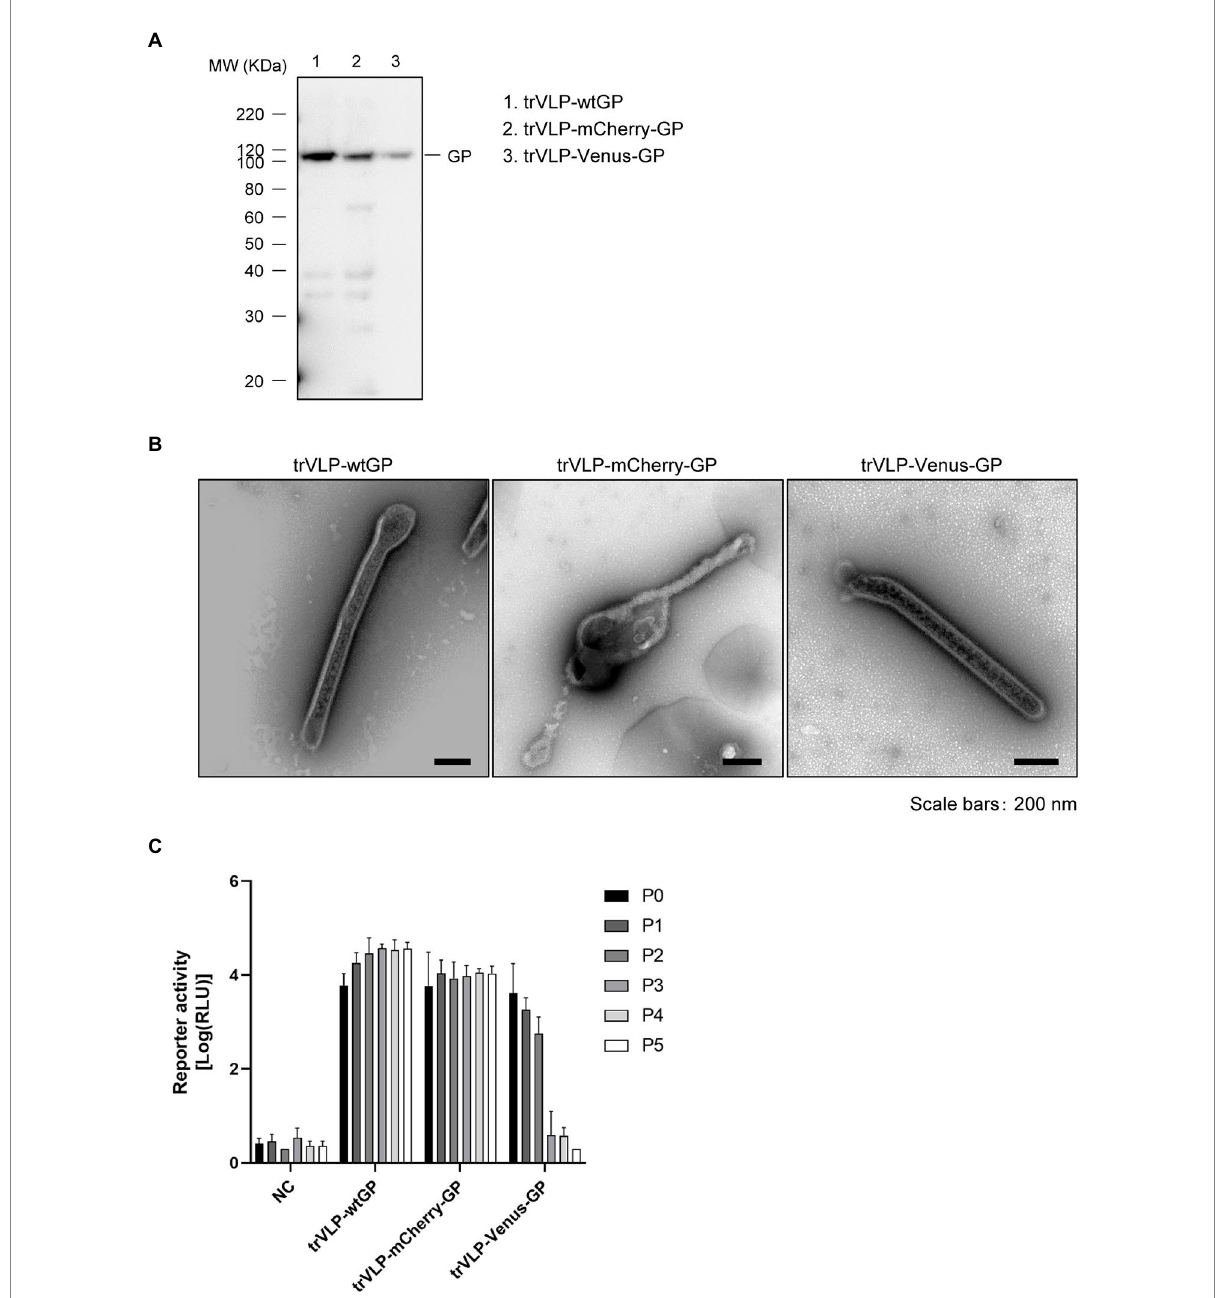
FIGURE 3 Establishment of EBOV trVLPs encoding the fluorescent protein-fused GP (A) Incorporation of the fluorescent protein-fused GP into the tetracistronic trVLPs. trVLP-wtGP, -mCherry-GP, or -Venus-GP released into culture supernatant of transfected-HEK293 cells (P0) were purified by ultracentrifugation. Incorporation of GP derivatives into purified trVLP was determined by western blot analysis. (B) Confirmation of morphology of tetracistronic trVLPs encoding the fluorescent protein-fused GP. Purified trVLP-wtGP (left), trVLP-mCherry-GP (middle), or trVLP-Venus-GP (right) were visualized by negative staining. Scale bars: 200 nm. (C) Reporter activities of trVLPs possessing a tetracistronic minigenome that encodes fluorescent protein-fused GP throughout multiple generations. Huh7 cells (P1) pre-transfected with expression plasmids encoding the RNP proteins were inoculated with culture supernatant of transfected HEK293 cells (P0). Seventy-two hpi, reporter activities were measured using the Dual-Luciferase Reporter Assay System. This infection was repeated every 72 h for 5 passages (P5). As a negative control, naïve HEK293 cells are shown. The means and standard deviations from 3 independent experiments are